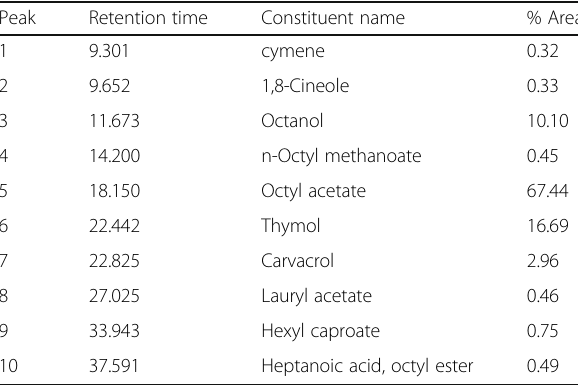
Table 1 GC/MC analysis of frankincense oil derived from Boswellia serrata